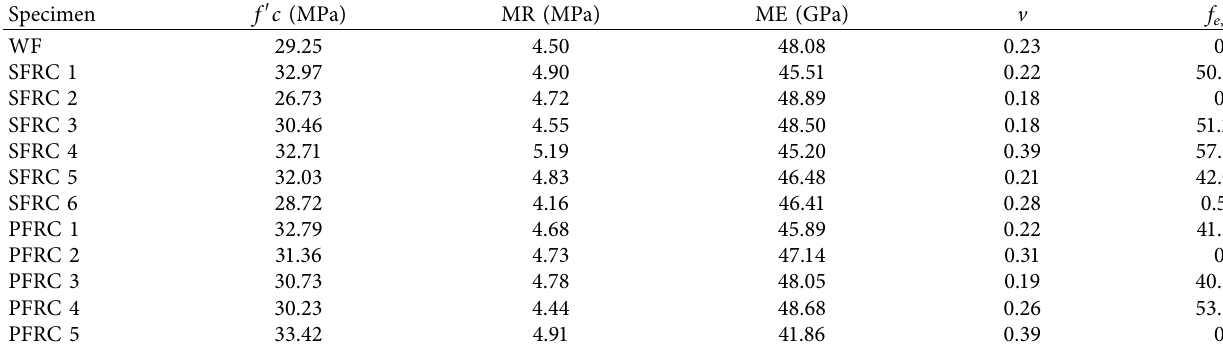
Table 6: Averages of the performed tests.